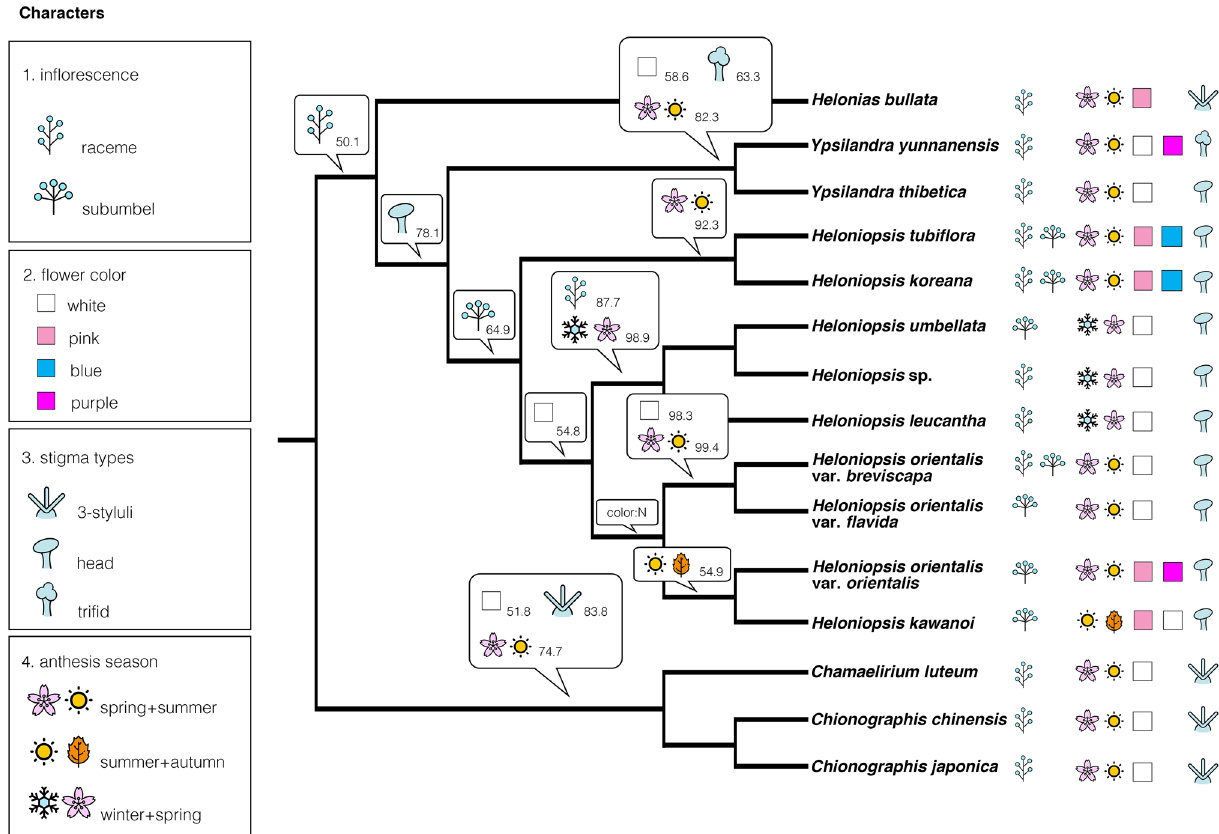
Figure 4. Evolution of changes in floral characters and anthesis period of Heloniadeae reconstructed by BayeTraits. Character states with probability > 50% were labelled on the node. Color: N represent the ancestral state was ambiguous on that node.